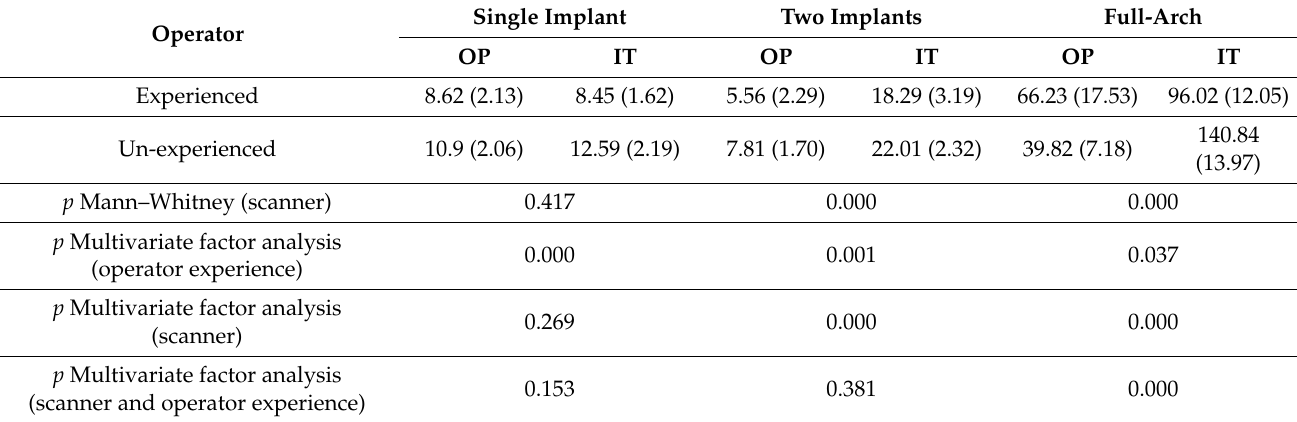
Table 1. Trueness (mean (SD)), in µ m. Trueness decrease in the full-arch scenario (OP opera system; IT Itero IOS). Single Operator